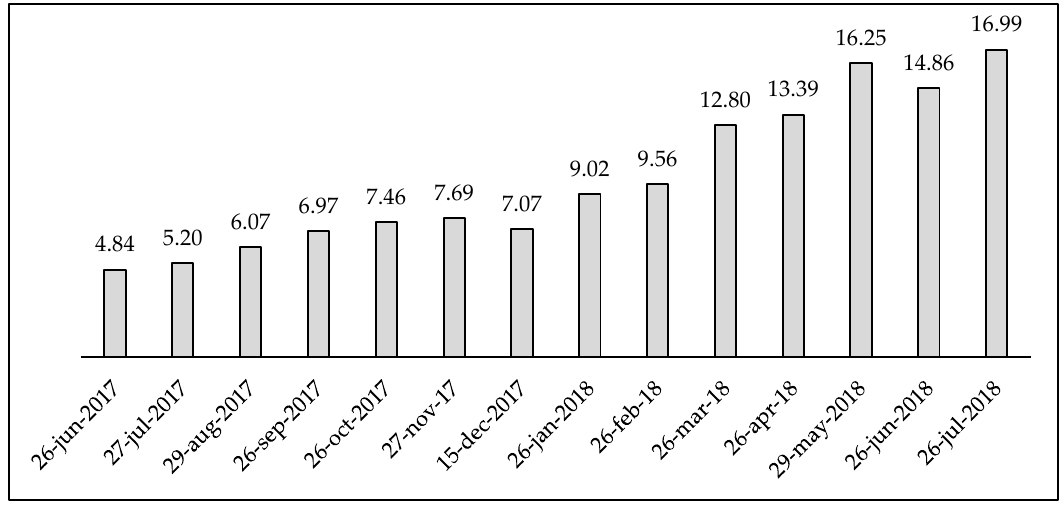
Figure 4. CO 2 European emission allowances. Data expressed in €/E UA (Markets Insider 2018).